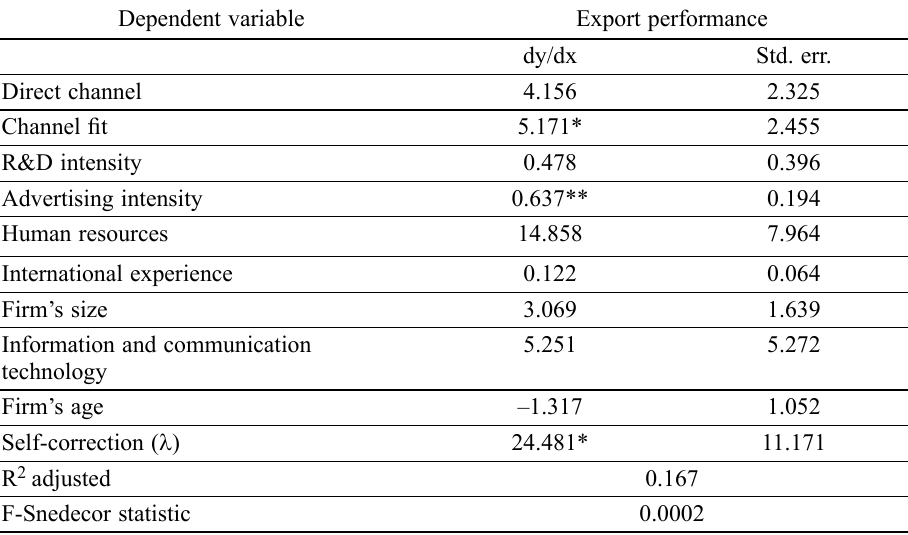
Table 4. Marginal effects for OLS regression models